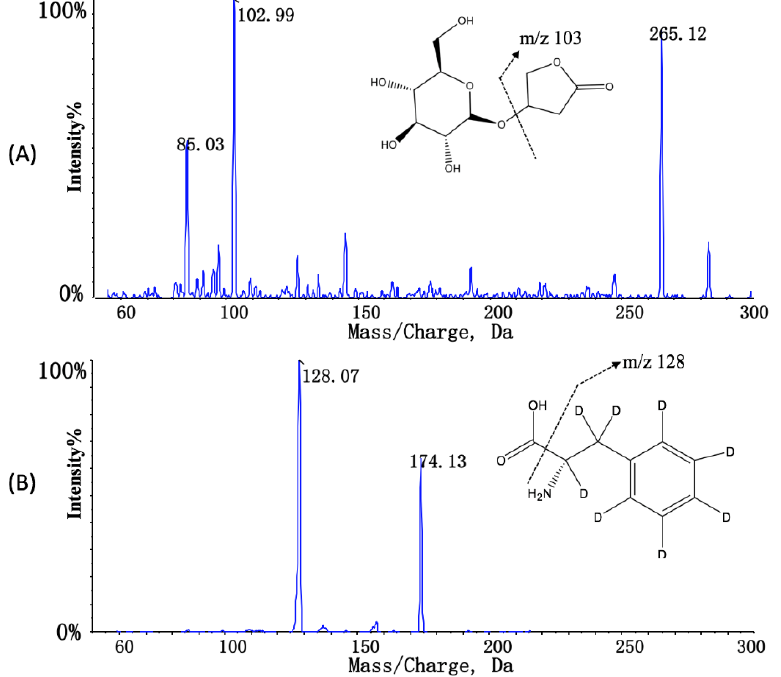
Figure 1. The chemical structures and characteristic diagnostic product ions of ( A ) kinsenoside and ( B ) internal standard.